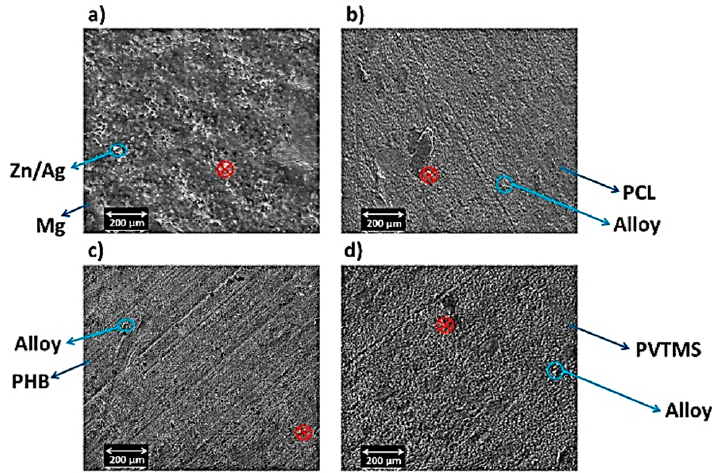
Figure 7. SEM images of ( a ) alloy, ( b ) C1, ( c ) C2 and ( d ) C3.